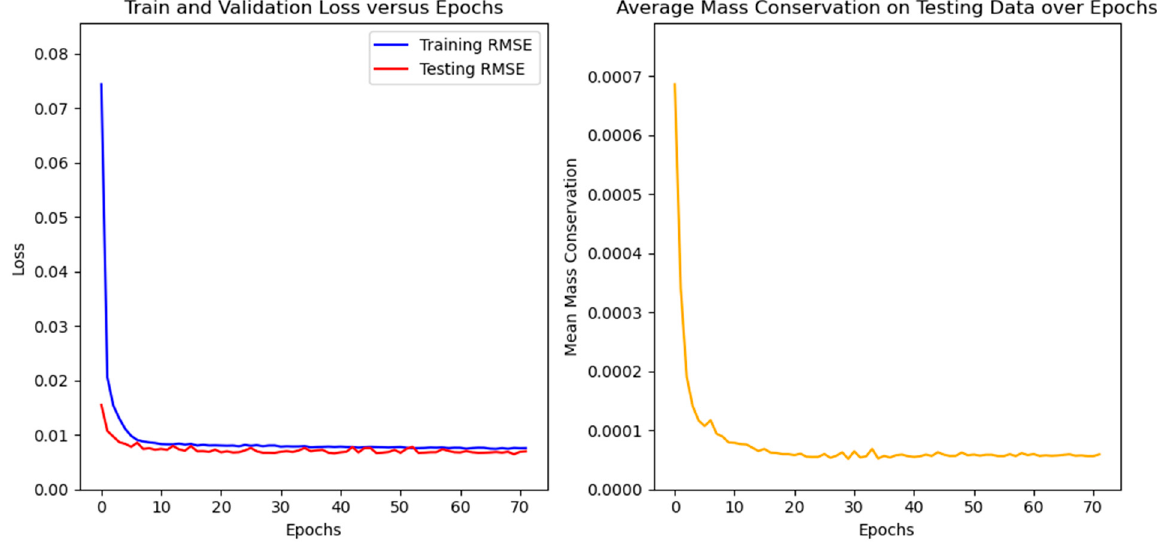
Figure 6. Loss function and mass imbalance error over the training epochs of the FNO model. Testing RMSE is also presented (red line, left plot).